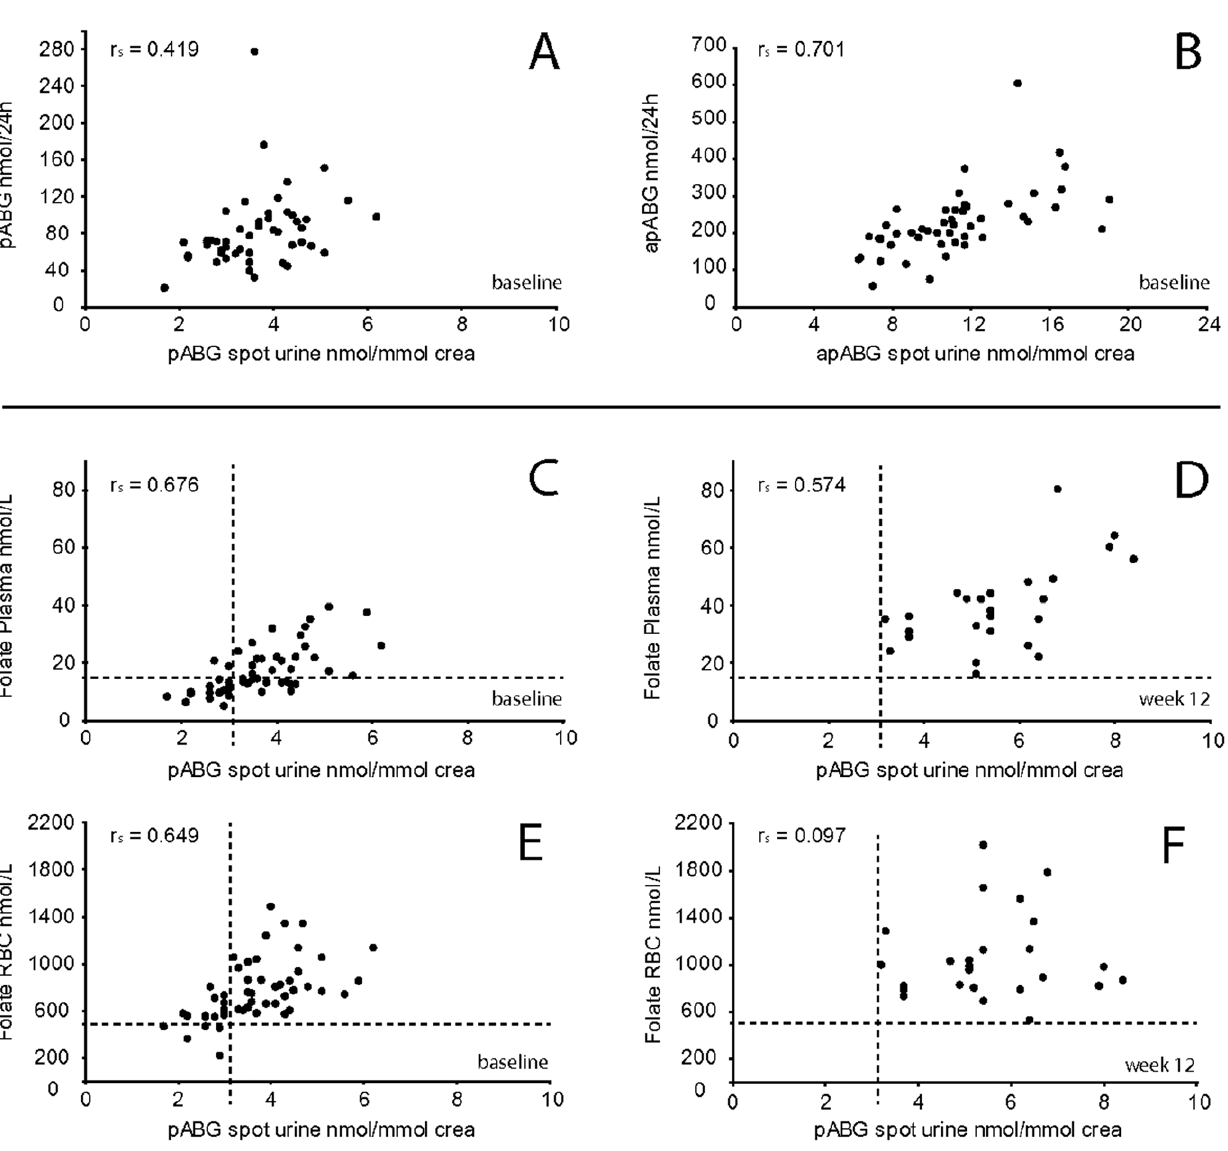
Figure 3. Correlation of folate catabolites in spot urine with 24 hour urine and blood folate concentrations. Comparisonoffolate catabolites in spot urine and 24 hour urine. Creatinine normalized concentration of para-aminobenzoylglutamate (pABG) (A) and para- acetamidobenzoylglutamate (apABG) (B) in spot urine is correlated with daily excretion in 24 hour urine. CorrelationsofurinarypABGwithplasma andredbloodcellfolate,acomparisonbetweenbaselineandweek12. Scatterplots for para-aminobenzoylglutamate (pABG)/creatinine in spot urine related to plasma folate and red blood cell folate concentrations, at baseline (C, E, n=51) and week 12 (D, F, n=25). For ease of comparison, dashed lines in C, D, E and F indicate the lowest value of the respective biomarker at week 12.